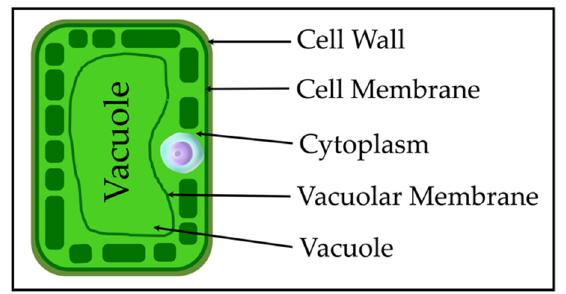
Figure 2. Architecture and constituents of a single plant cell.